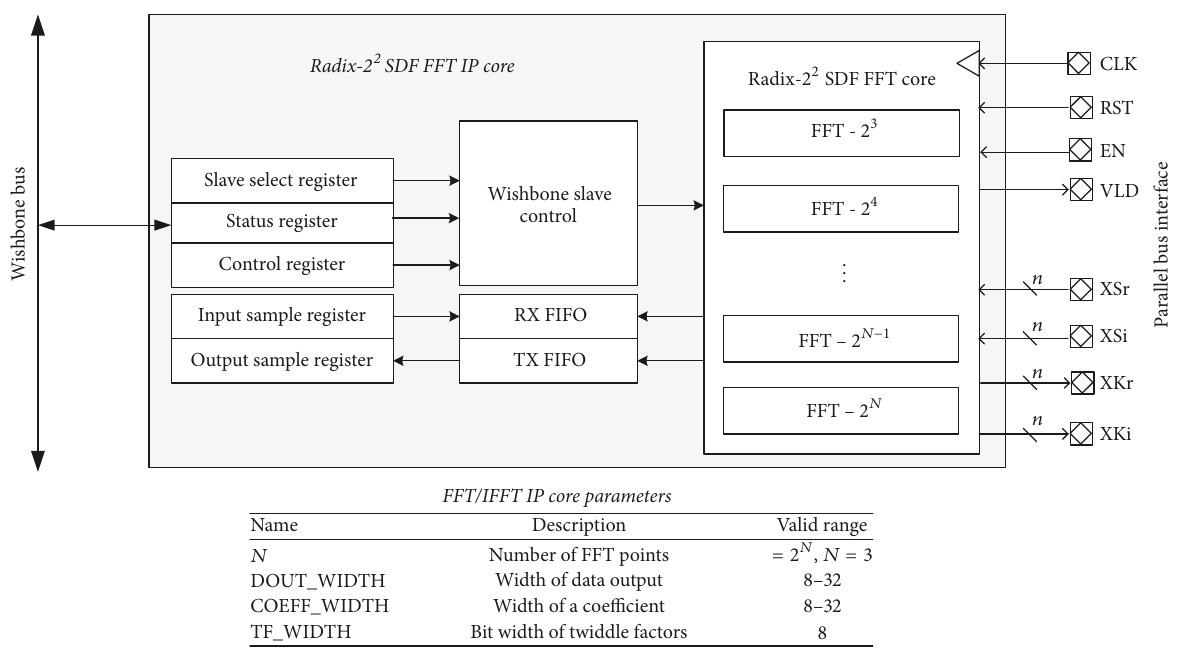
Figure 6: An architecture of the FFT IP core.